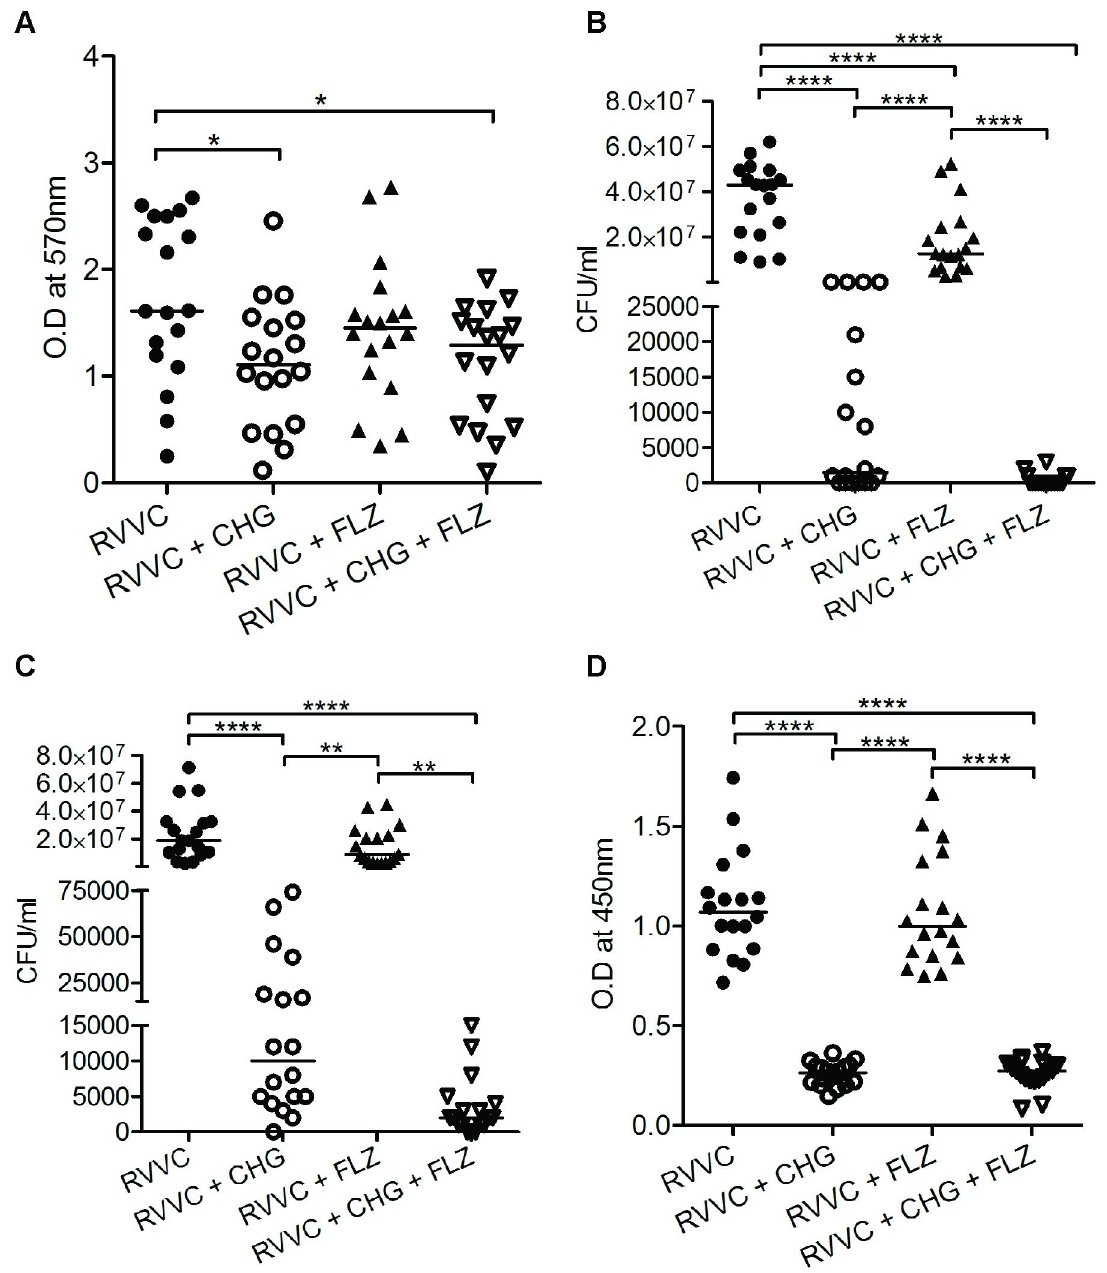
Fig 1. Chlorhexidine digluconate reduces already established biofilm and growth of C . albicans isolates from patients with RVVC. The effect of chlorhexidine digluconate (CHG) 0.02% and fluconazole (FLZ) 4 μ g/ml and the combination CHG + FLZ compared to untreated C . albicans was investigated on RVVC strains (n = 18). For RVVC, density of established, mature, biofilm, measured with crystal violet staining (A), viable count of planktonic C . albicans ( B) and of C . albicans within mature biofilm ( C) . Metabolic active cells within the mature biofilm, measured with XTT assay (D). Individual and median values are presented, depicted as optical density (OD) at 570 nm after dissolution of crystal violet, and at 450 nm for soluble product of formazan crystal after reduction of XTT. � p < 0.05, �� p < 0.01, ��� p < 0.001 and ���� p <